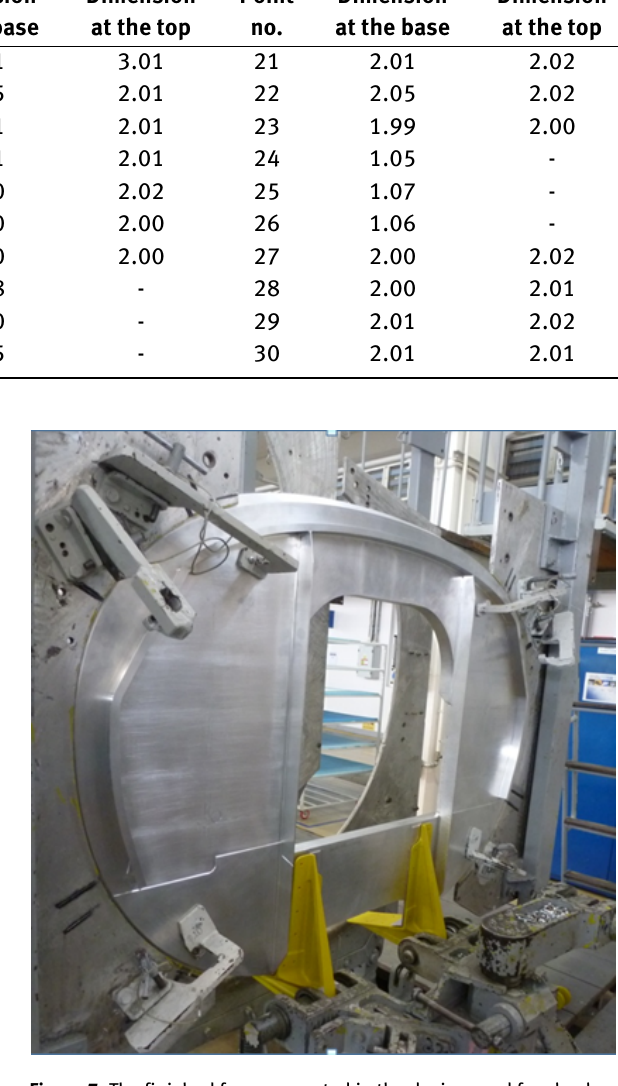
Figure 7: The finished frame mounted in the device used for check- ing the aircraft frames